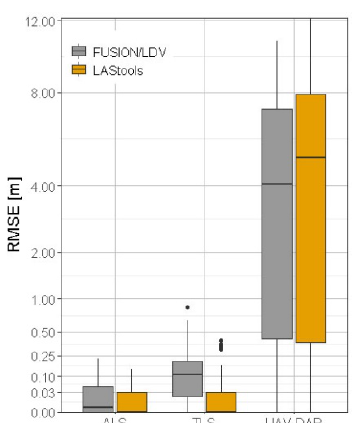
Figure 5. Vertical profiles representing from left to right: ( i ) a point cloud transect of 1.5 m wide, and ( ii ) the density computed from the point cloud transect according to the number of points. These profiles represent for two contrasted plots, (a) P27_SP003 and (b) SP1003